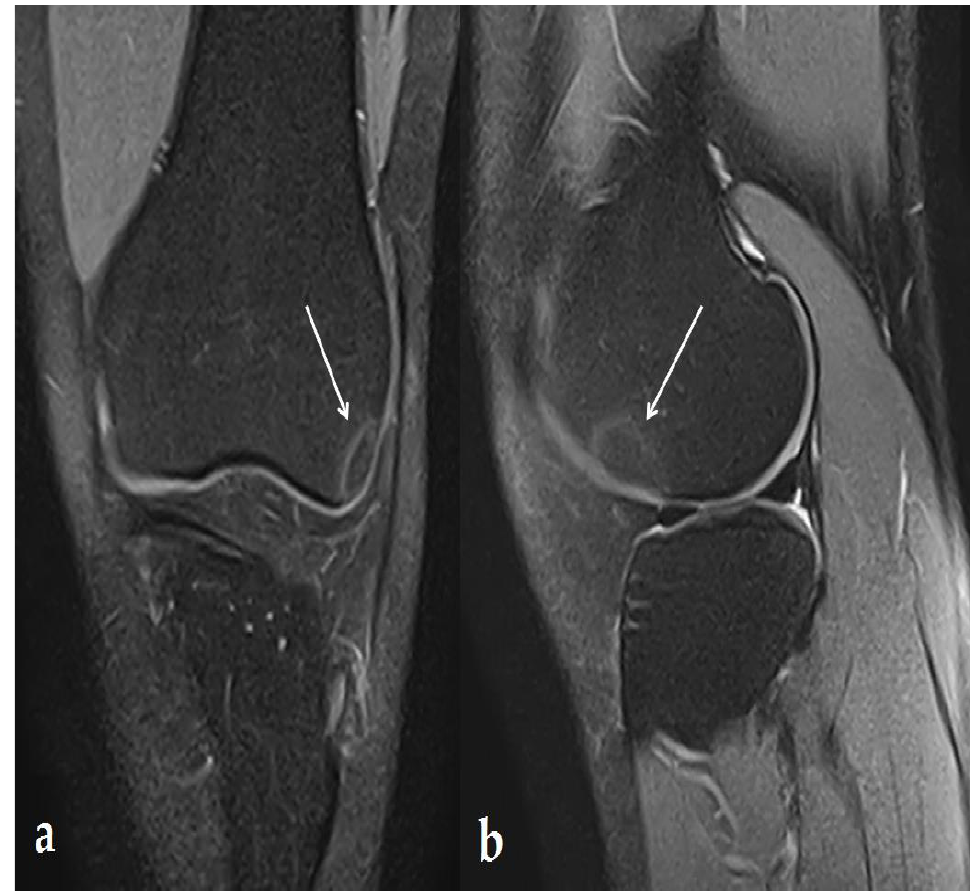
Figure 1. MRI: 1 month before the first US therapy. DP FS MRI image in frontal ( a ) and sagittal ( b ) section demonstrating a single (13 × 14 × 16 mm) lesion under the epiphyseal cortex of the lateral femoral condyle with peripheral border in hyper-intensity, highlighted with white arrows.